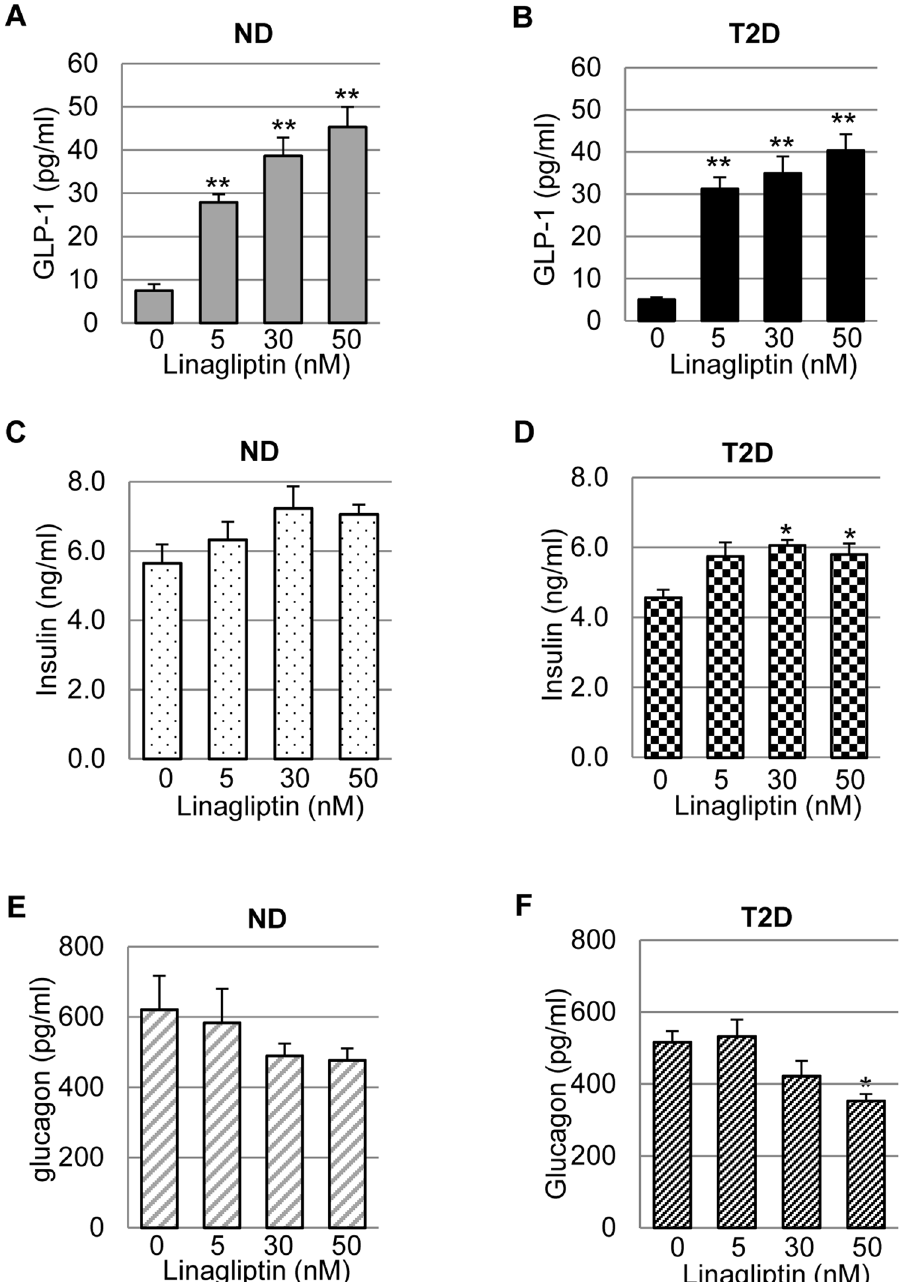
Figure 2. Basal GLP-1, insulin and glucagon secretion in cultured human islets following linagliptin treatment. Human islets isolated from ND and T2D donors were cultured at a density of 150 IEQ/0.5 ml in the presence of 0, 5, 30, and 50 nM linagliptin for 3 days with daily media refreshing. The media was collected and used to measure GLP-1 ( A , B ), insulin ( C , D ), and glucagon ( E , F ) concentrations using corresponding ELISA kits. Shown are representative data obtained from the 3 rd day culture. All data were normalized with the total protein of islet lysates that were collected at the end of the experiments (per ug protein), and expressed as Mean ± SEM. * p < 0.05; ** p < 0.01 when compared to untreated